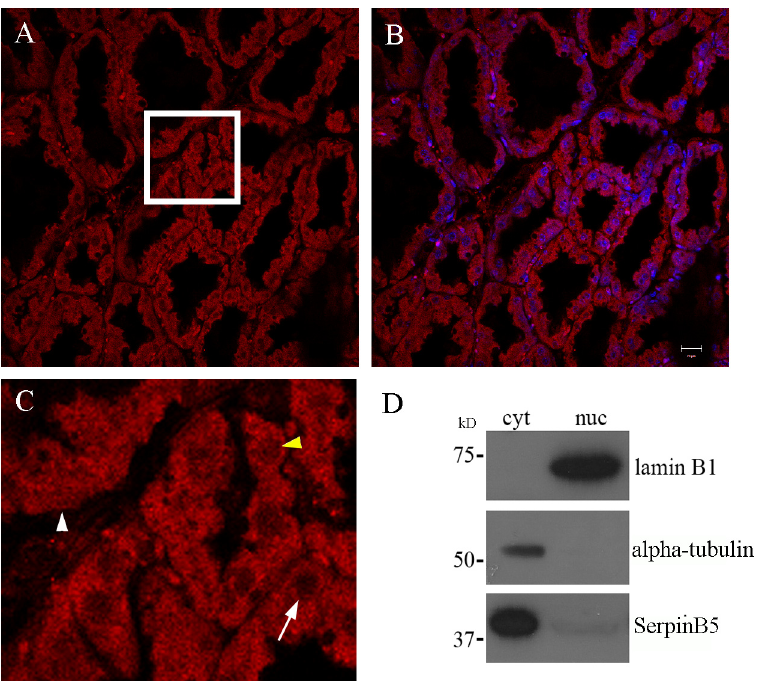
Fig 6. SerpinB5 subcellular localization in the mouse mammary gland. A. SerpinB5 immunofluorescence staining (Sigma) on paraffin section of a 10 day lactating gland; B. SerpinB5 and DAPI merge image; C. Representative area enlarged from boxed region indicating a SerpinB5-positive nucleus (white arrowhead), a partially-positive nucleus (yellow arrowhead) and a SerpinB5-negative nucleus (white arrow). D. 50 ug of nuclear (nuc) and cytoplasmic (cyt) protein fractions of a 10 day lactating mammary gland were subjected to 12% SDS-PAGE, transferred to PVDF membrane and probed with anti-SerpinB5